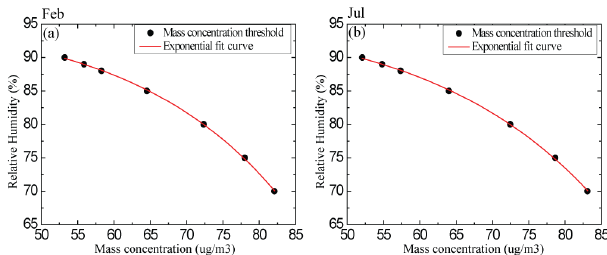
Figure 16. The relationship between regional- and monthly-average PM 2 . 5 mass concentration threshold of haze occurrence and relative humidity in Beijing. Also shown are the exponential fitting